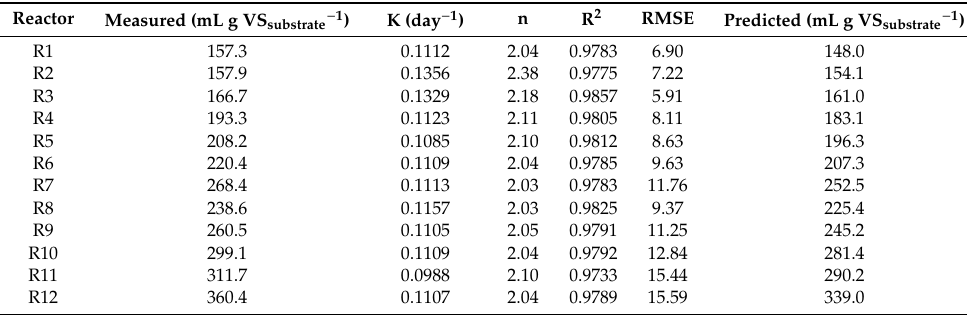
Table 4. Results of the kinetic study using the cone